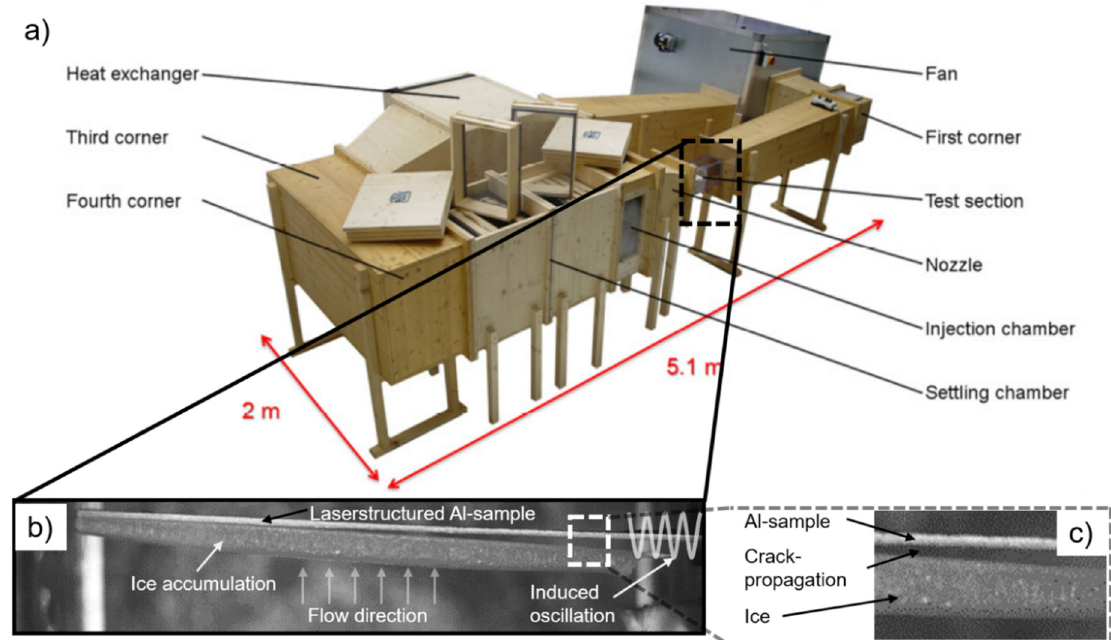
Figure 2. Icing wind tunnel iCORE (icing and Contamination Research facility), which allows adjusting the wind speed and temperature by accessing a fan and a heat exchanger. The droplet size and stream water content in the test section are set by the settling and injection chambers before the nozzle ( a ) [51]. In the test section, ice accumulates on the laser-structured sample, and the specimen is exposed to mechanical shear stress due to induced oscillation ( b ), which finally leads to crack propagation ( c ).